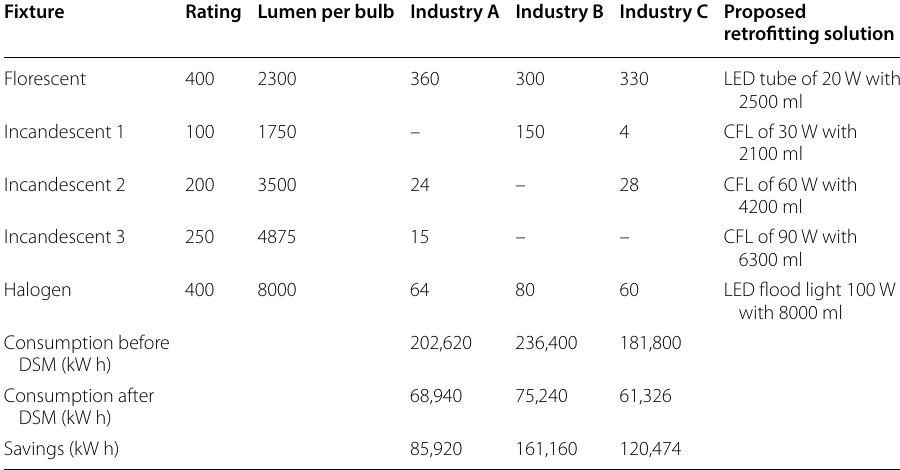
Table 7 Lighting calculations for industry A–C